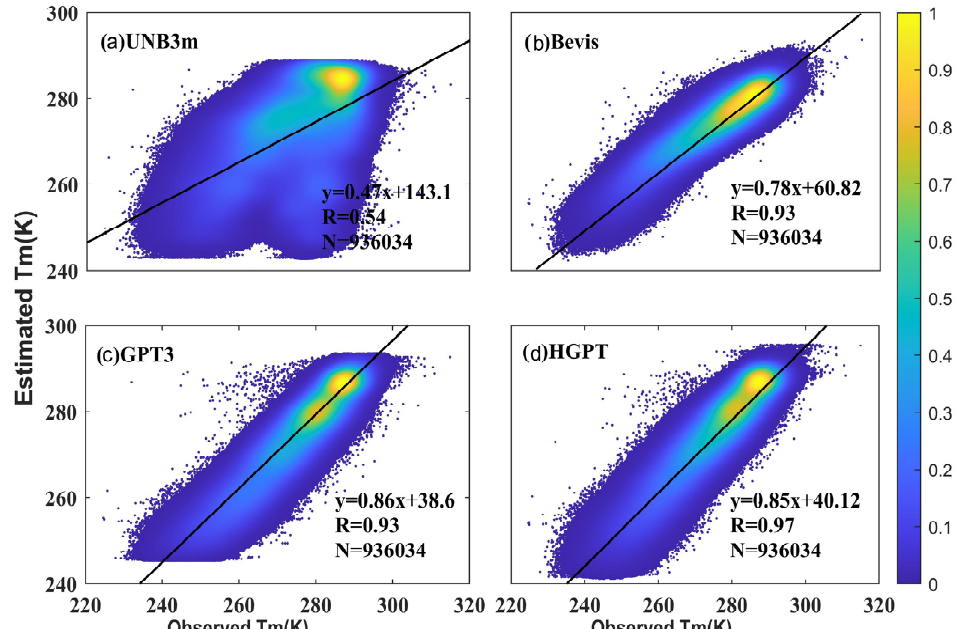
Figure 7. Scatter plots of estimated T m against T m derived from radiosonde data for different models: ( a ) UNB3m model; ( b ) Bevis model; ( c ) GPT3 model; ( d ) HGPT model. (The cut in the GPT3 ( c ) is due to there being no data in that range.)